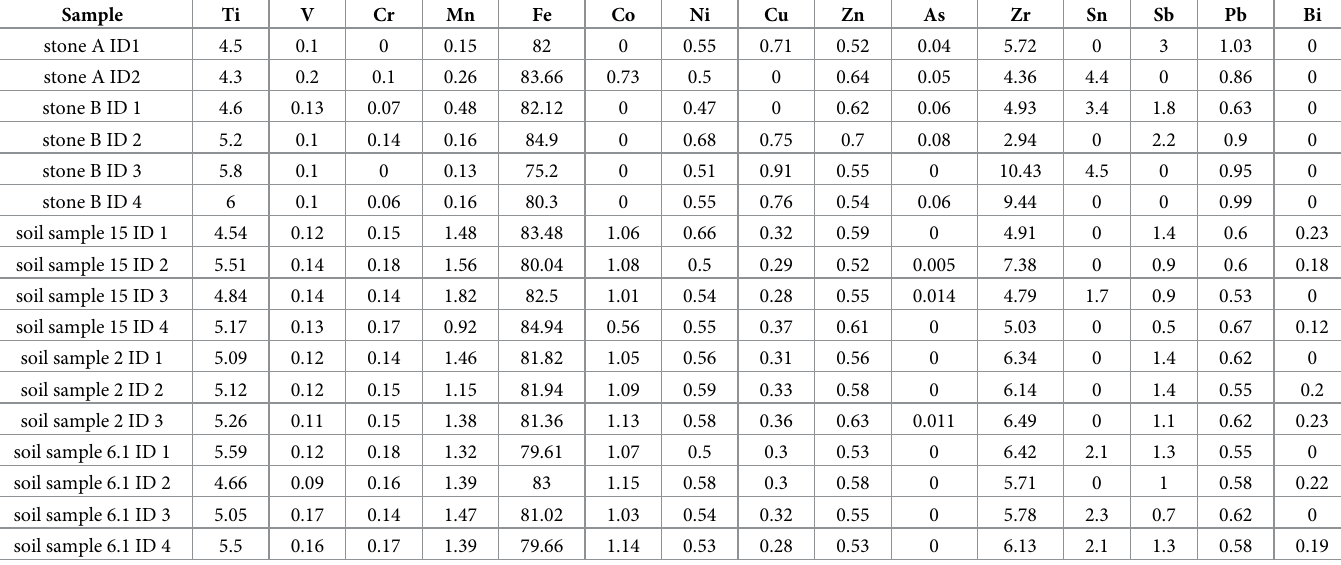
Table 3. Results of the X-ray fluorescence measurements of two samples of sandstone from Bleichenbach and samples of the soil immediately surroundning the statue 1.